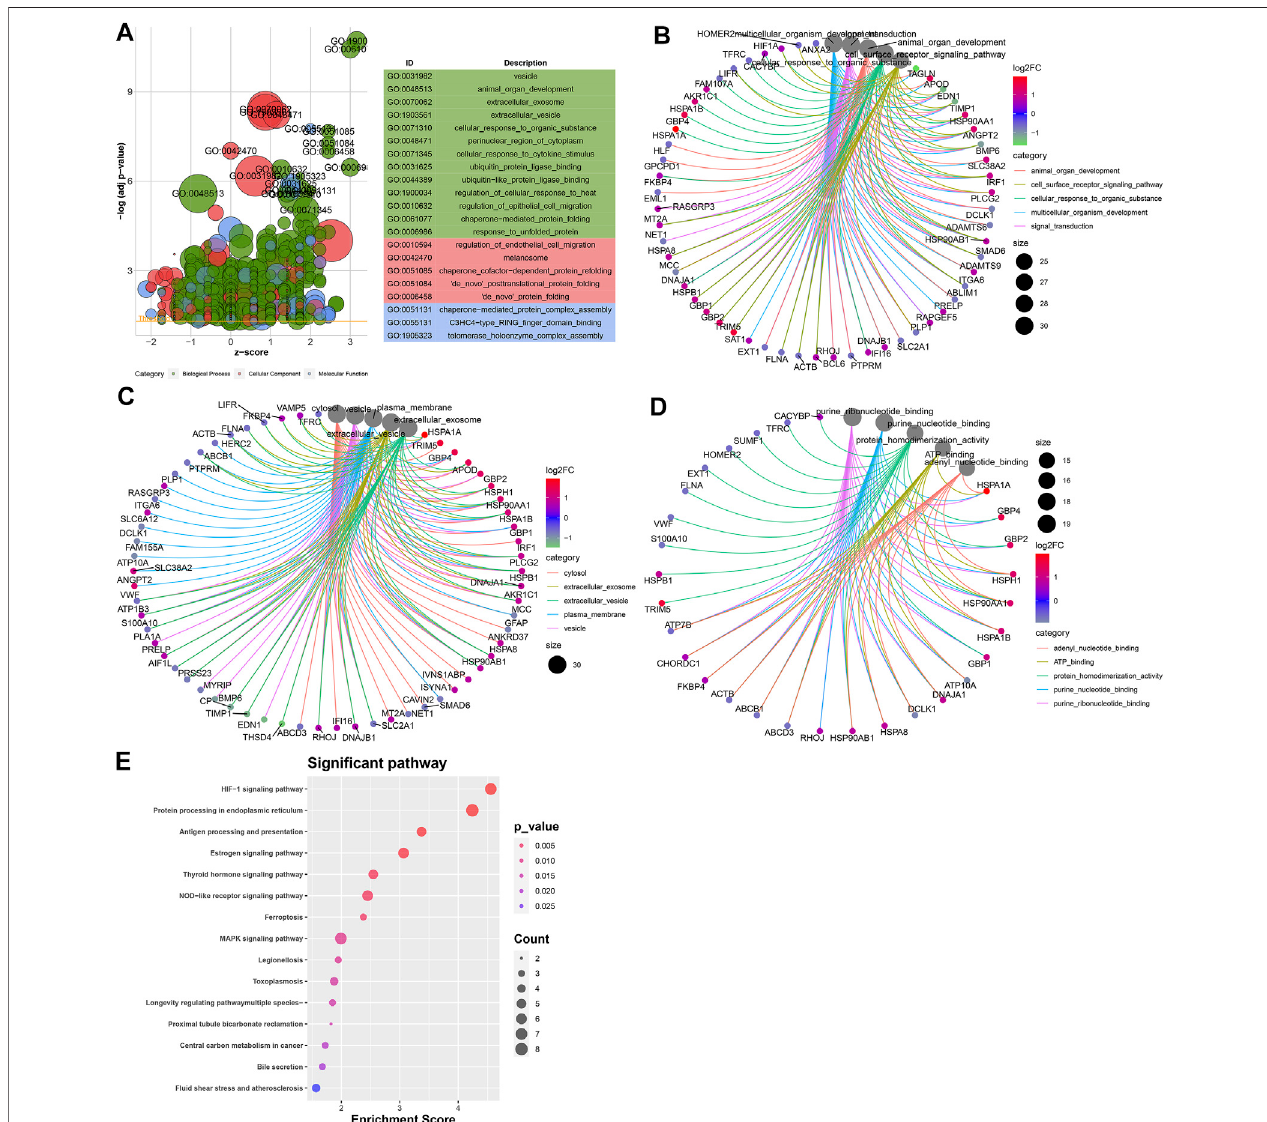
FIGURE 5 | Potential biological functions of DEGs in endothelial cells. (A) Bubble chart for the top 20 GO enrichment results including the biological process (BP; green), cellular component (CC; red), and molecular function (MF; blue). Core networks for the top fi ve (B) BP, (C) CC, and (D) MF terms and enriched genes. (E) Heat mapforthetop15KEGGpathwaysandenrichedgenes.Thecellcolorrepresentsthe|log2FC|ofgenes.Thewarmcolorindicatesupregulatedgenes,andthecoolcolor indicates downregulated genes.